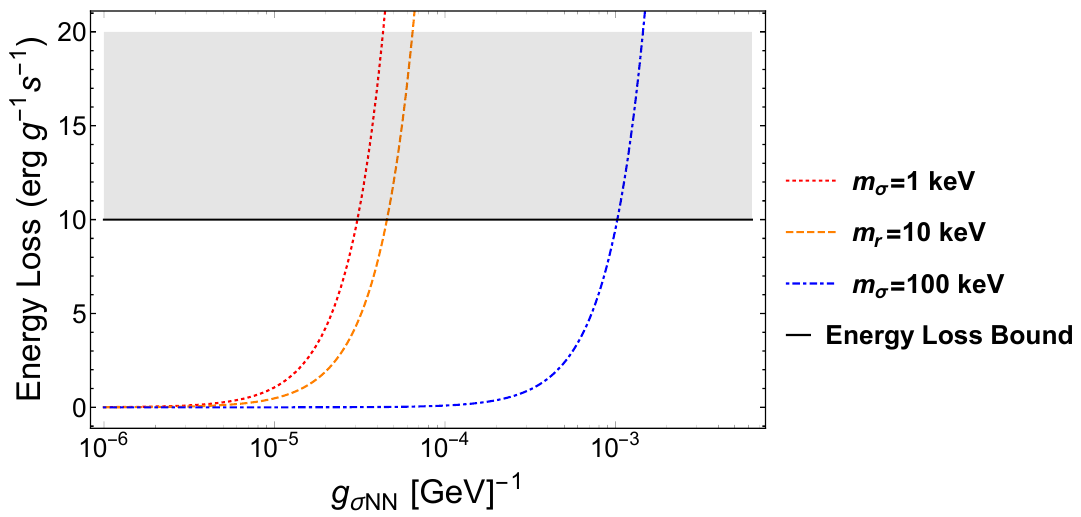
Figure 7. The energy loss rate by radions including only the interaction with nucleons. The red-dotted line represents m (cid:27) = 1 keV, orange-dashed m (cid:27) = 10 keV and blue-dot-dashed for m (cid:27) = 100 keV. The black-solid horizontal line marks the bound (5.14).